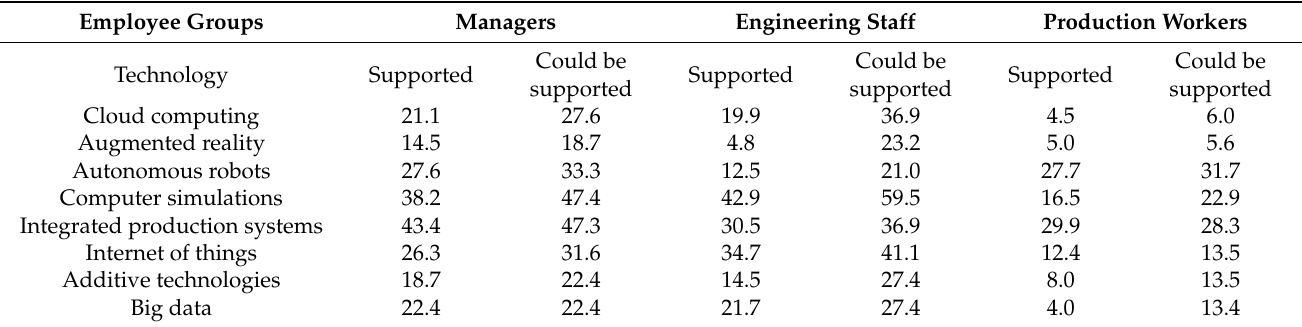
Table 4. Workplace vs. use of various aspects of Industry 4.0 and stated need for